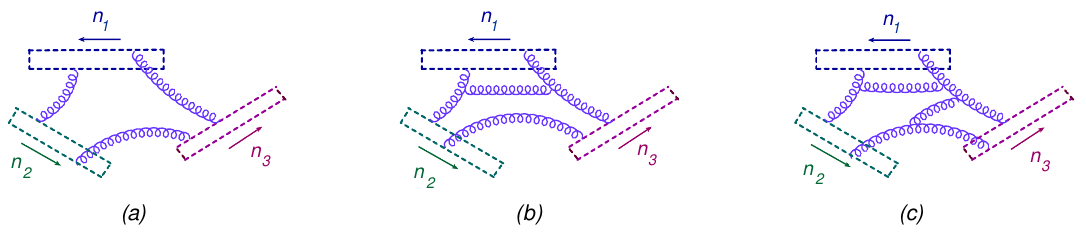
Figure 12 . Typical diagrams for correlator of three Wilson frames in the leading order (a), at the one-loop level (b) and at the two-loop level